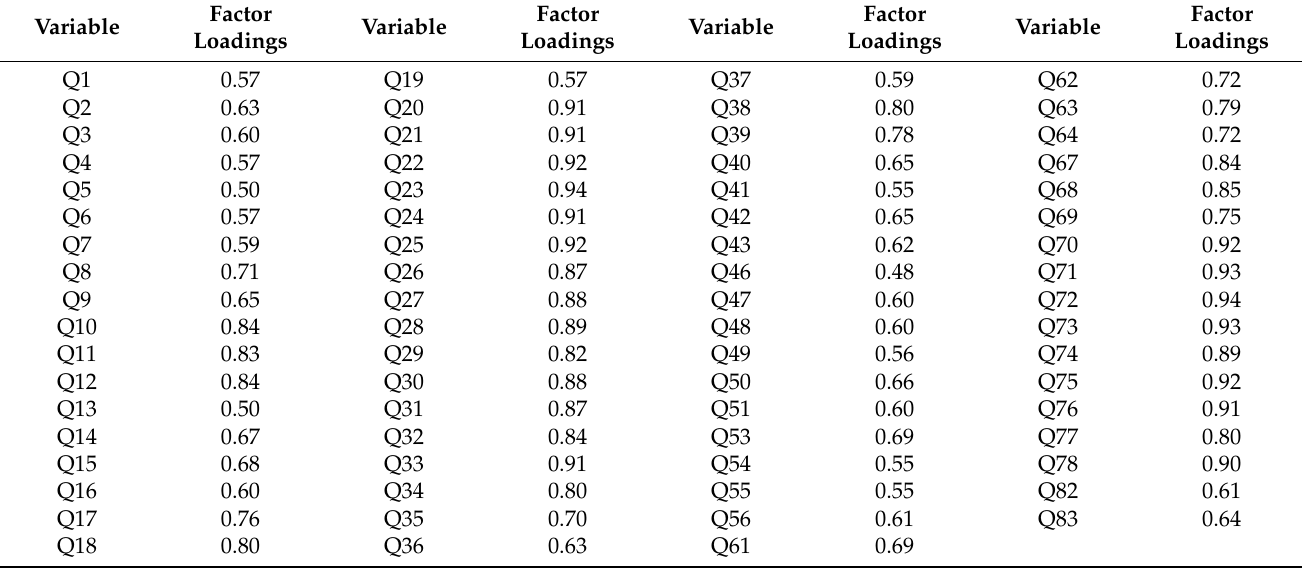
Table 2. Factorial loadings of the questionnaire’s 71 items. The questions are numbered in accordance with the original